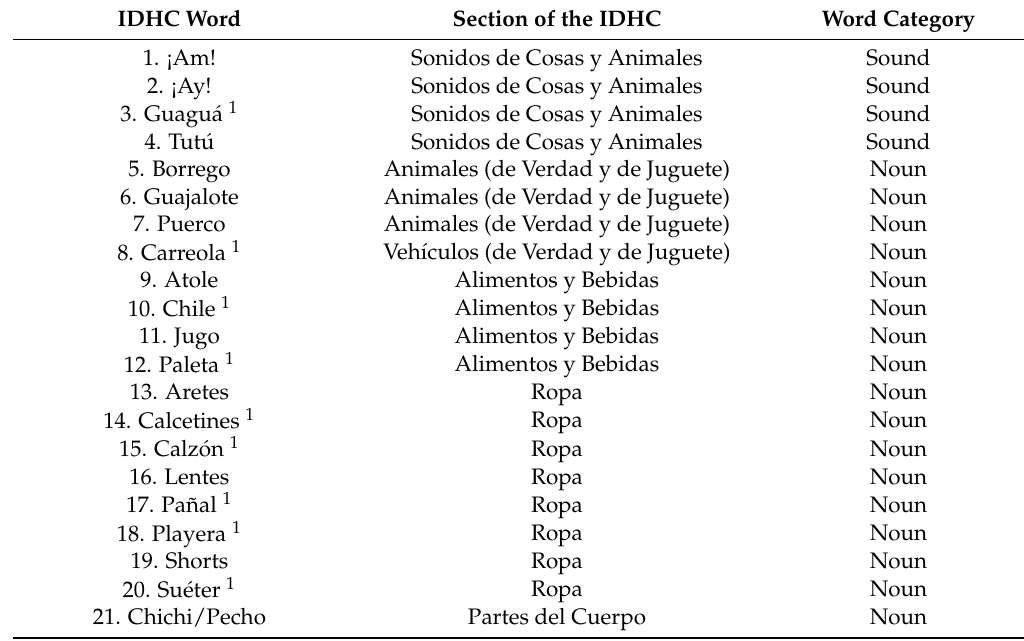
Table A2. Unknown/uncommon IDHC words identified by the mixed Hispanic